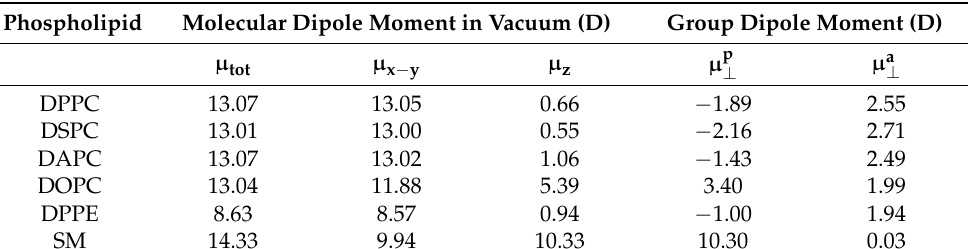
Table 2. Values of dipole moments and their contributions, calculated using Gaussian software for entire molecules and their selected parts in vacuum. Phospholipid Molecular Dipole Moment in Vacuum (D) Group Dipole Moment (D)